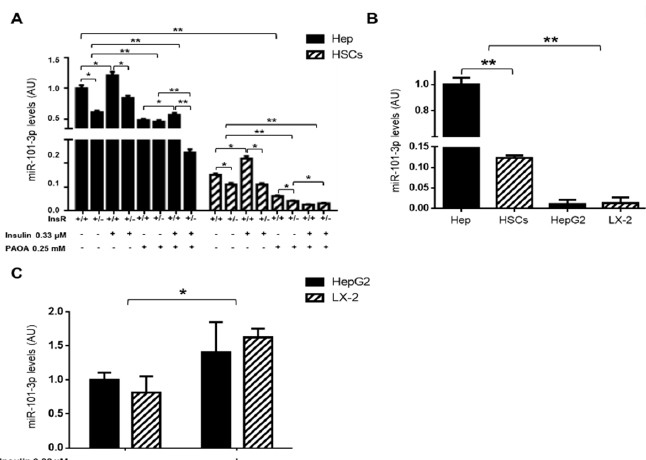
Figure 6. miR101b-3p expression was further reduced in in vitro models of IR-NASH and in high proliferating cells. Expression of miR-101-3p in wt and InsR +/ − hepatocytes (Hep) and HSCs exposed to insulin (0.33 µ M, for 6 h) alone or in a combination with palmitic (PA) and oleic (OA) acids (ratio 1:2, final concentration 0.25 mM, for 24 h) ( A ). Expression of miR-101-3p in primary mouse hepatocytes (Hep) and HSCs, and in human immortalized hepatoma cells (HepG2) and HSCs (LX-2) ( B ). Expression of miR-101-3p in HepG2 and LX-2, exposed to insulin (0.33 µ M, for 6 h) ( C ). The expression was evaluated by qRT-PCR and normalized for hsa-miR-361-5p, hsa-miR-186-5p, hsa-miR-26a-5p, hsa-miR-191-5p, hsa-miR-451-5p, and hsa-miR-423-5p average expression and expressed as fold increase compared to untreated wt (InsR +/+ ) hepatocytes or HepG2 cells (arbitrary units—AU). At least three independent experiments were conducted (* p < 0.05, ** p <